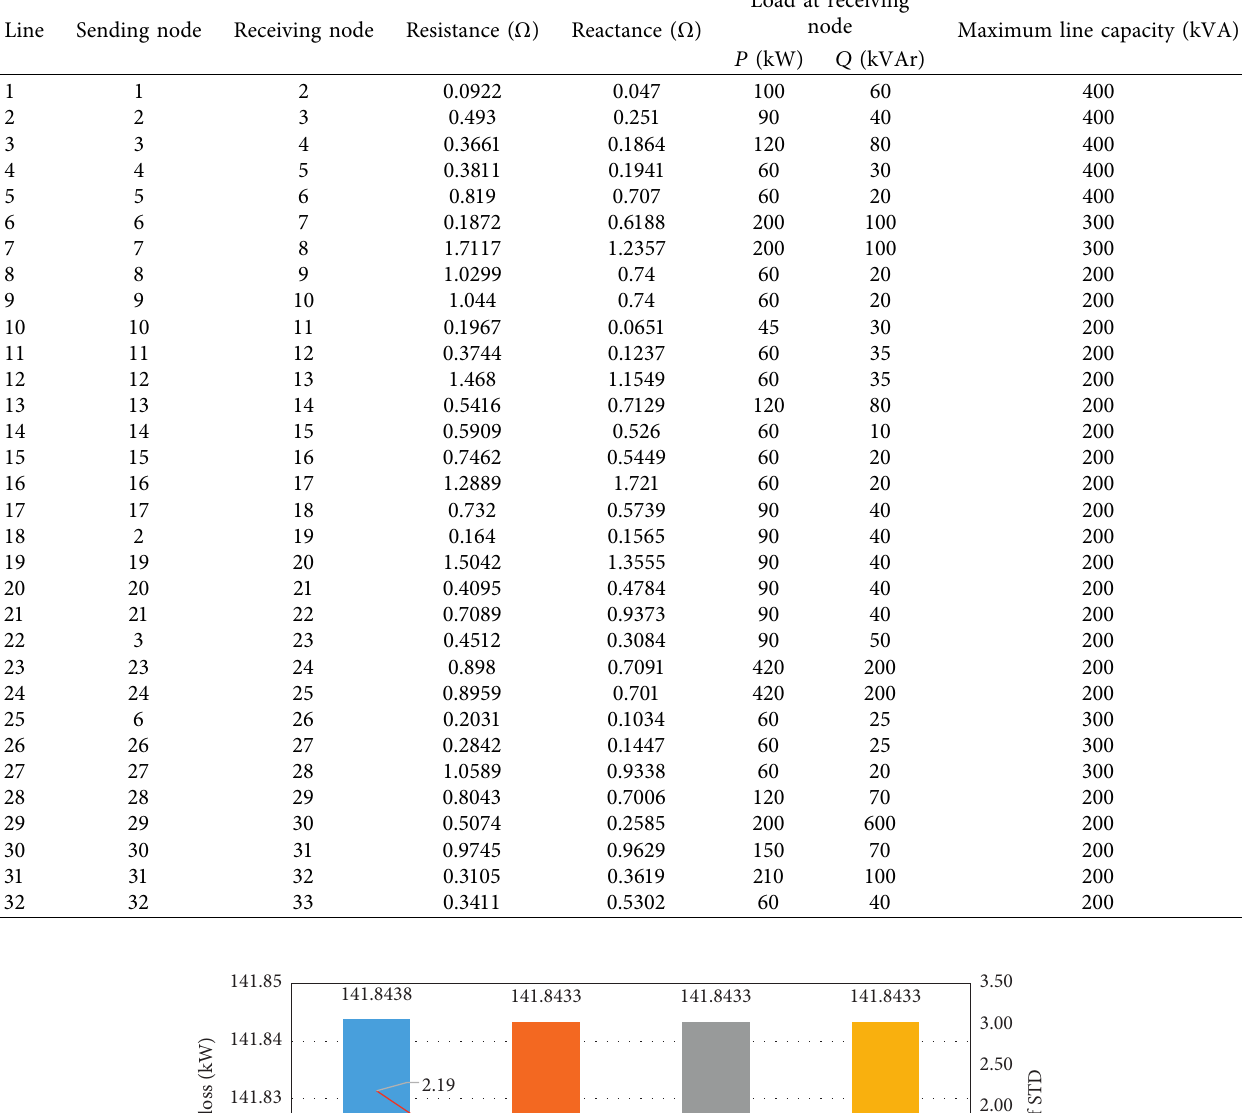
Table 1: Data of the first system with 33 buses.